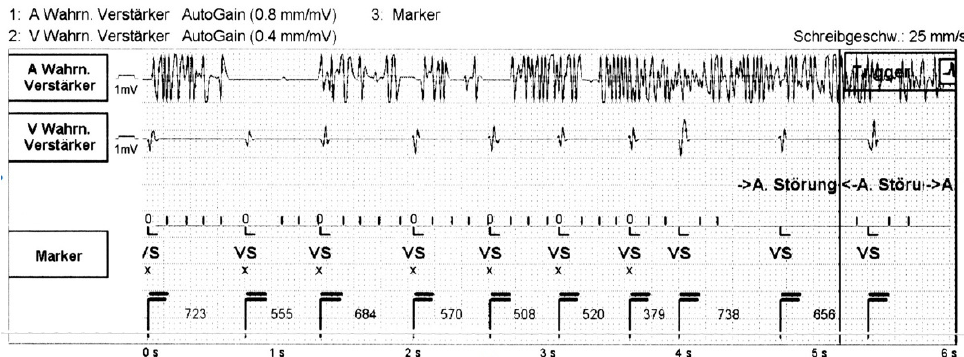
Figure 2. Right atrial lead defect. Artifacts in the atrial EGM (A, first line) documented during preoperative interrogation of a CRT device with an already known isolation defect of the atrial lead (inactivated, impedance < 100 Ω ). There is no noise on the ventricular (V) lead channel (middle line). Paper speed 25 mm/s. VS. = ventricular sensed event. “A. Störung” = atrial noise detection. Table 3. Preoperative CRT interrogation. Observations and adverse findings already known from patient’s history or according to the device ID card in 39 patients.